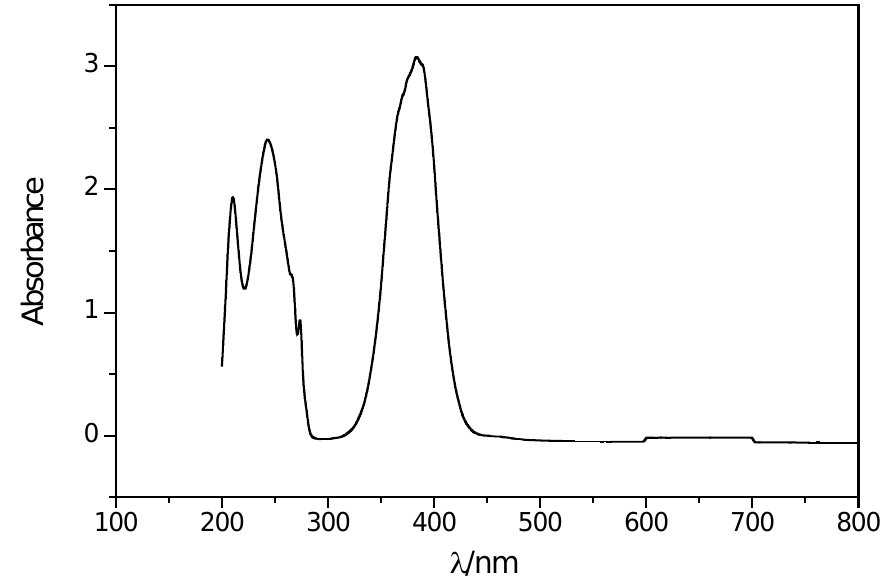
Figure 6. UV-Vis spectra of the title compound.